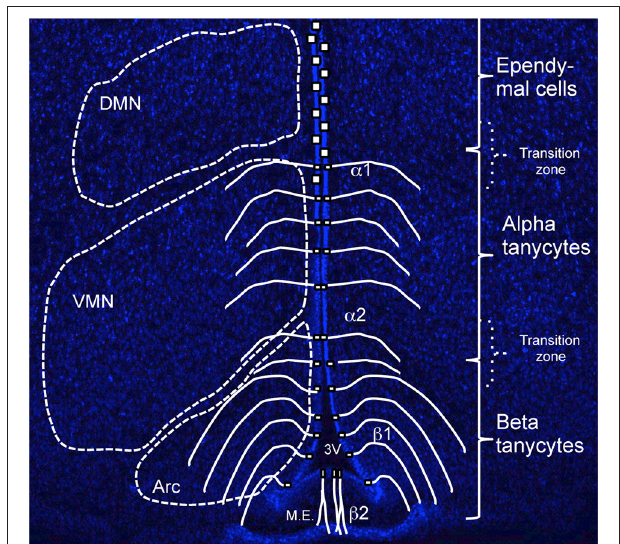
FIGURE 1 | Organization and distribution of hypothalamic tanycytes. Coronal section of adult hypothalamus at approximate bregma -1.5 labeled with Hoechst to highlight parenchymal neuronal nuclei, Dorsomedial (DMN), Ventromedial (VMN), and Arcuate (Arc) that flank the third ventricle (3V) at this bregma. Superimposed is a schematic depicting the domains of tanycyte subtype ( β vs. α ) and ependymal cells. Note that the dorso-ventral extent of these domains, as well as the flanking parenchymal nuclei varies depending on bregma level (see Figure 2 ). M.E., Median